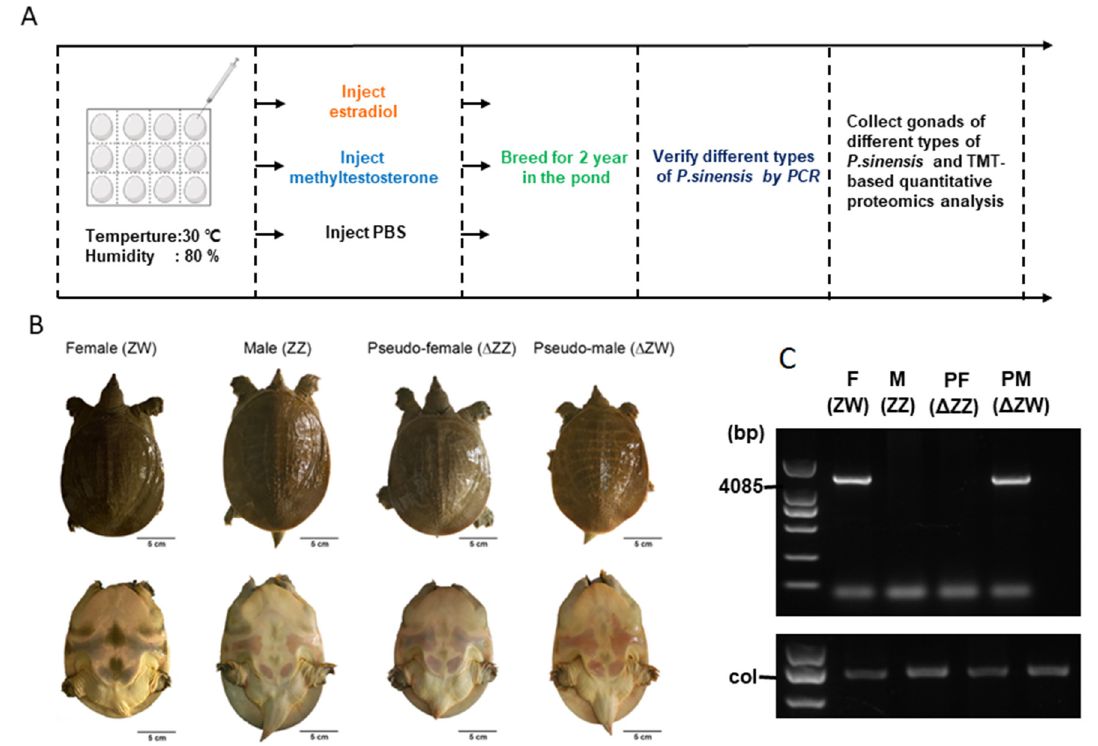
Figure 1. Acquisition of pseudo-female and -male of Chinese soft-shelled turtles. ( A ) The basic workflow of this experiment. ( B ) Appearances of the four types of Chinese soft-shelled turtles. ( C ) Verification of the four types of Chinese soft-shelled turtles. F: female, M: male, PF: pseudo- female, PM: pseudo-male, PBS: phosphate-buffered saline, PCR: polymerase chain reaction, TMT: tandem mass